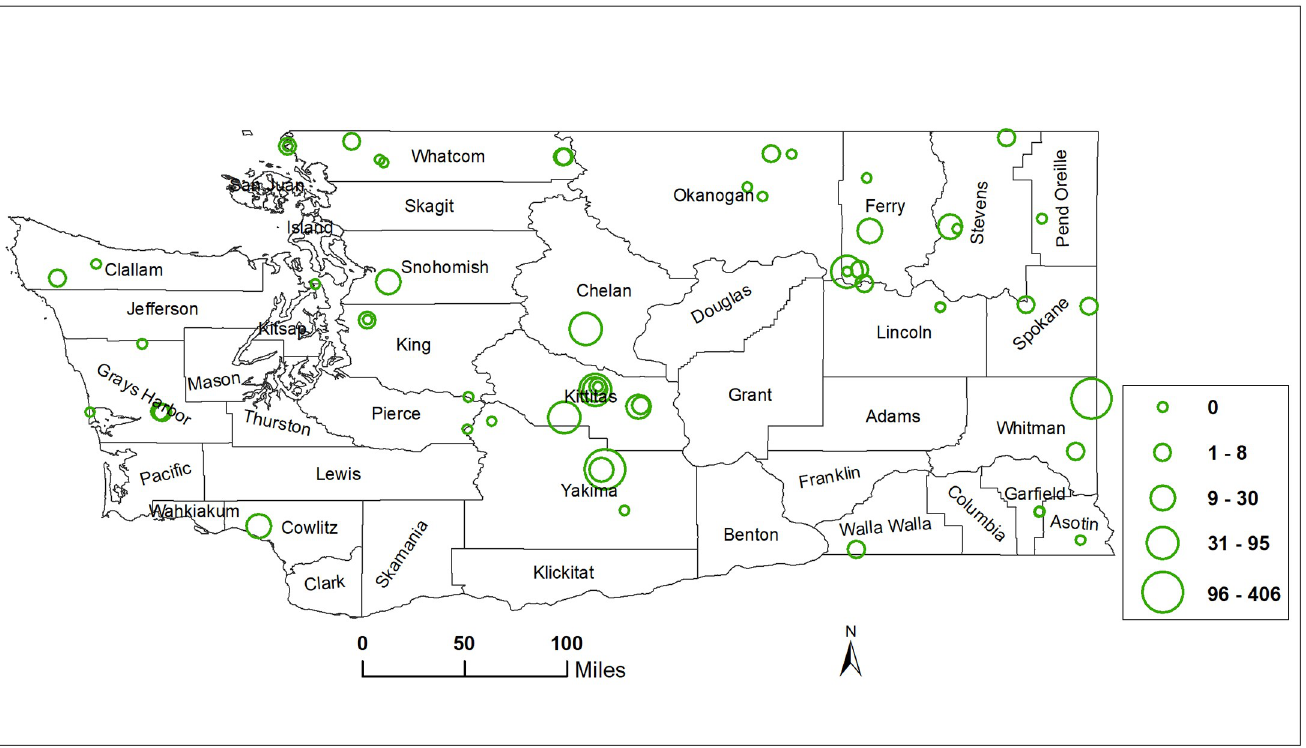
Fig 4. Abundance of R . indifferens in Washington State, U.S.A. Abundance data collected from 61 sites in 2015 and 2016 were averaged and classified into 5 classes using the natural breaks classifier in ArcGIS [43].